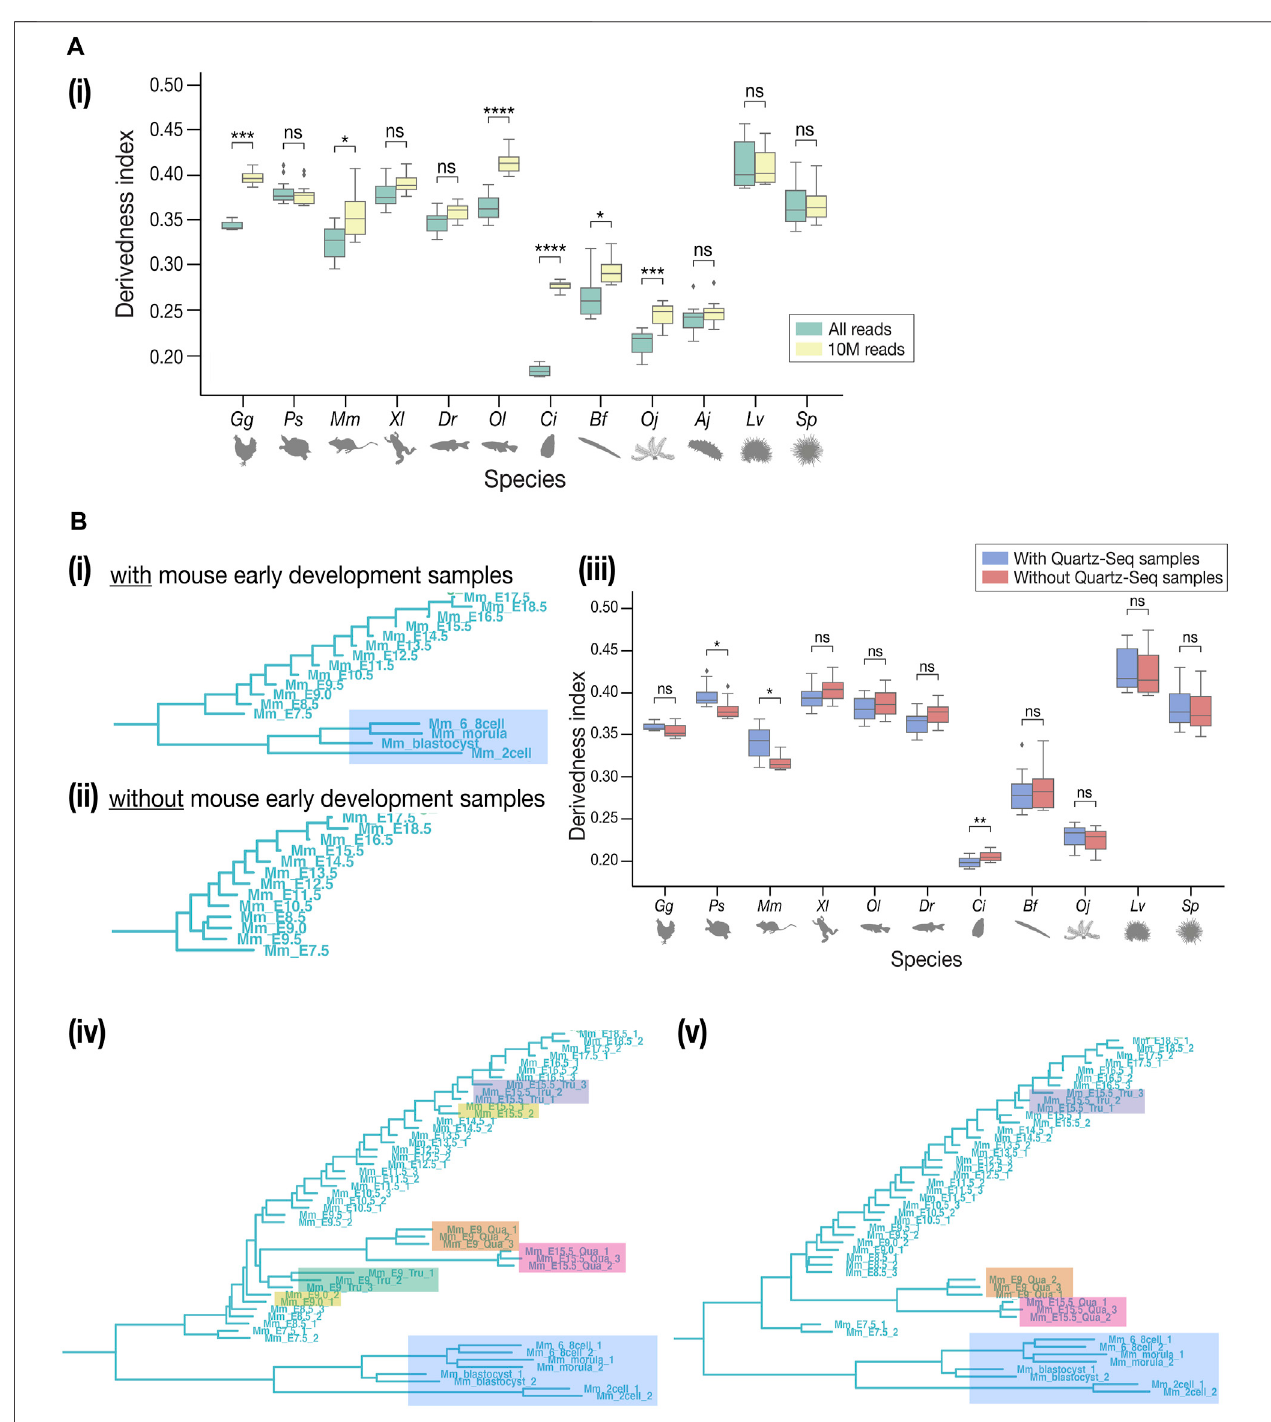
FIGURE 6 | Technical concerns in derivedness tree inference. (A) Read depth control. (i) In the tree inferred from 10 M-controlled expression data, the range of derivedness indices signi fi cantly increased in some species ( Gg , Mm , Ol , Ci , Bf , and Oj ). (B) Comparison of TruSeq and Quartz-Seq datasets. (i) The samples of early developmentin mouse(shadedinblue) andall samplesofsea cucumber(not shown) werecollected byQuartz-seq. (ii) RemovingtheQuartz-seq sampleschanged the tree topology insidethe mouse clade.The leastderivedstage became E9.5. (iii) AfterremovingtheQuartz-seqsamples,the rangeofderivedness indicesfor most specieswerenotgreatlyaffected,notin fl uencingtheconclusionswedrewintheprevioussessions. (iv – v) Treewithalloriginalsamplesandthenewsamplestocompare TruSeq & Quartz-seq datasets. Unexpectedly, the samples tend to cluster by protocols rather than by stages or biological replicates. This tendency is stronger in (v) wherethe E9.0TruSeqsampleswere omitted, while theE15.5Quartz-seqand Tru-Seq samplesstill did notcluster together. Samplesfrom the same startingtotal RNA